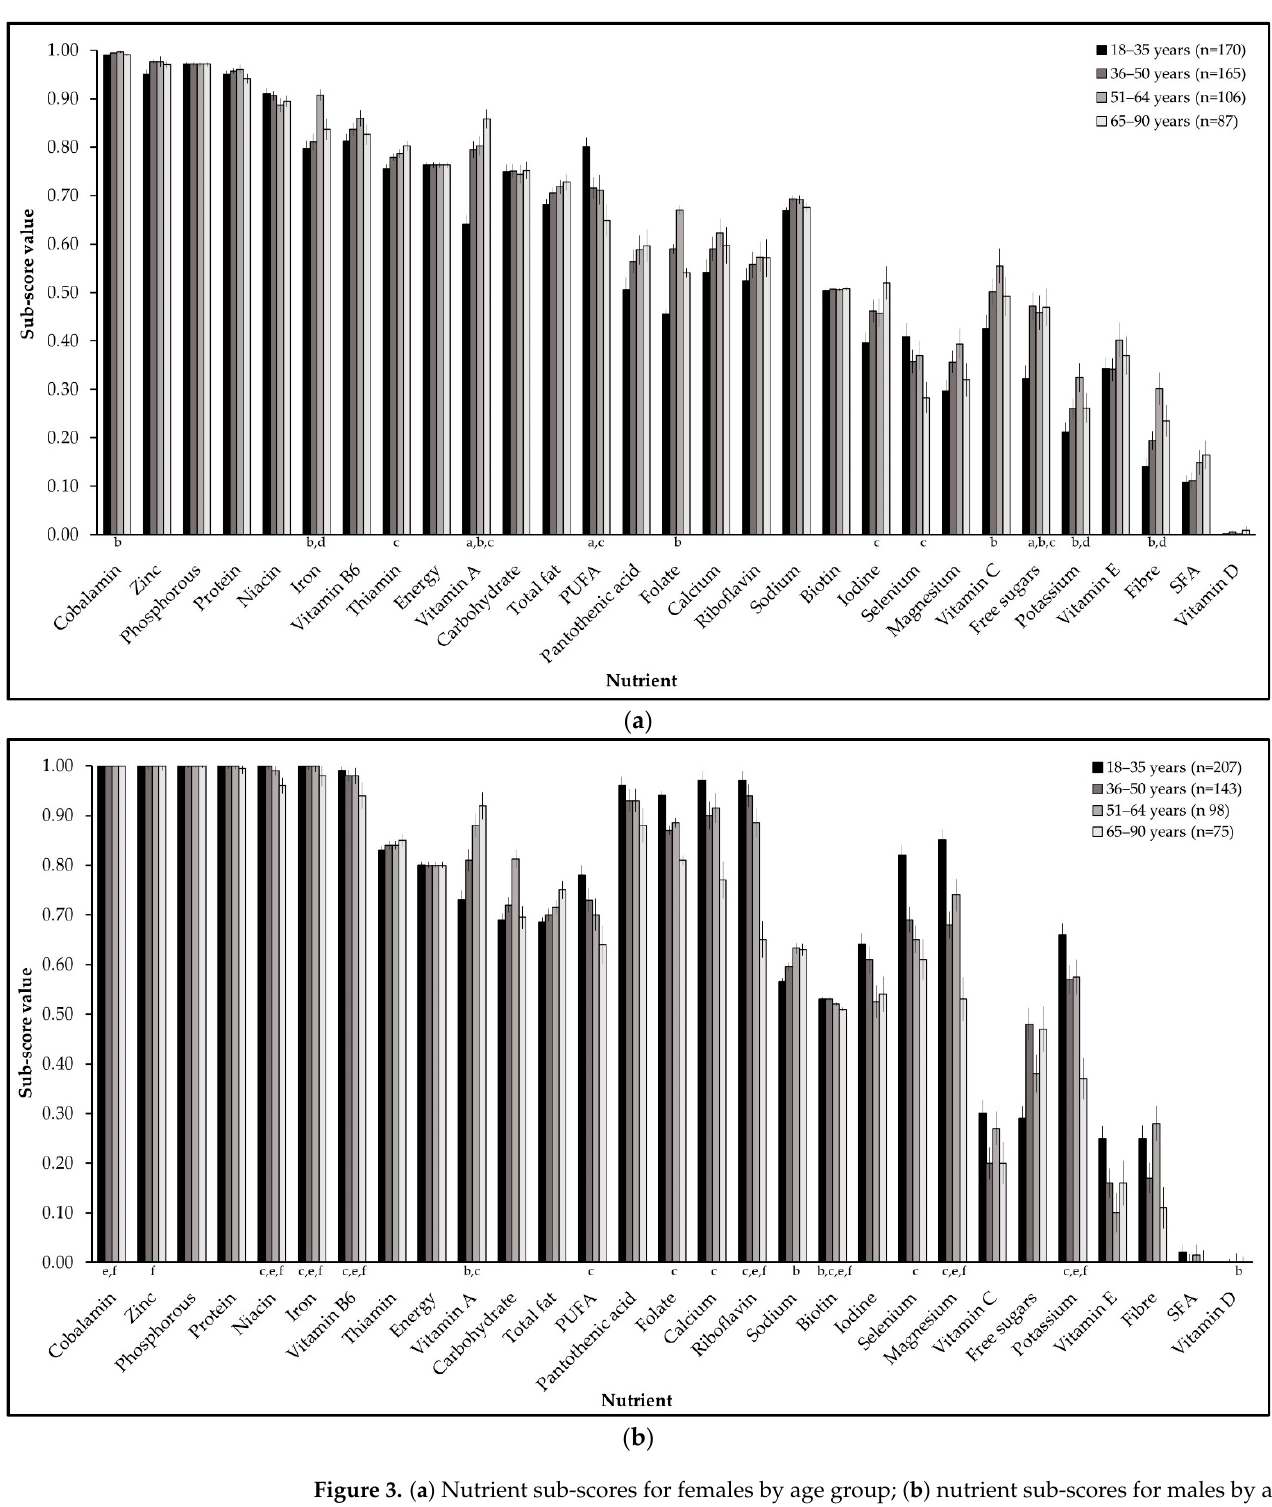
Figure 3. ( a ) Nutrient sub-scores for females by age group; ( b ) nutrient sub-scores for males by age group. Values shown as median ± std. error. SFA = saturated fatty acids. PUFA = polyunsaturated fatty acids. Significance from ANCOVA with Bonferroni corrections for multiple comparisons indicated as: a. between 18–35 and 36–50 age groups; b. between 18–35 and 51–64 age groups; c. 18–35 and 65–90 age groups; d. 36–50 and 51–64 age groups; e. 36–50 and 65–90 age groups; f. 51–64 and 65–90 age groups ( p < 0.05).